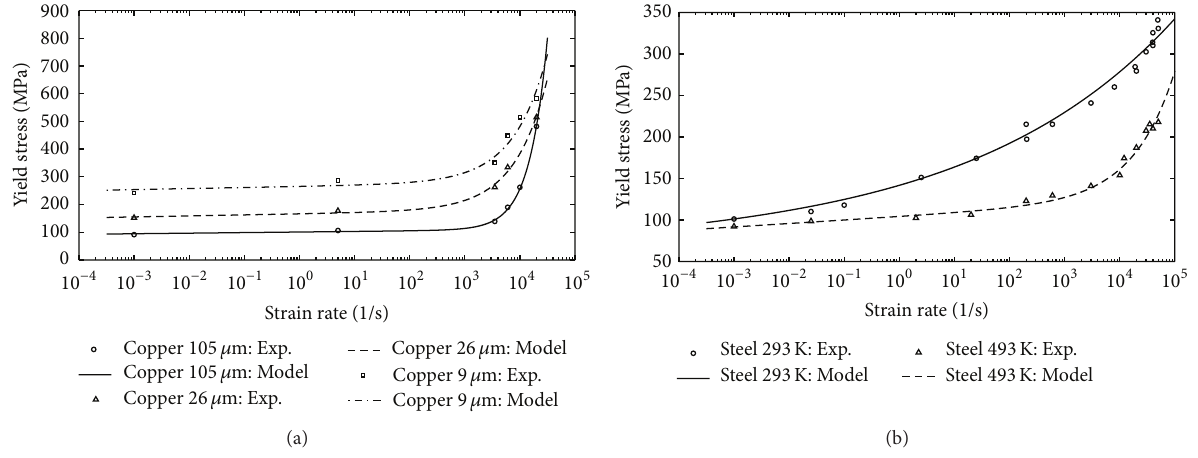
Figure 4: Yield stress fitting by the Couque model: (a) copper and (b) steel.